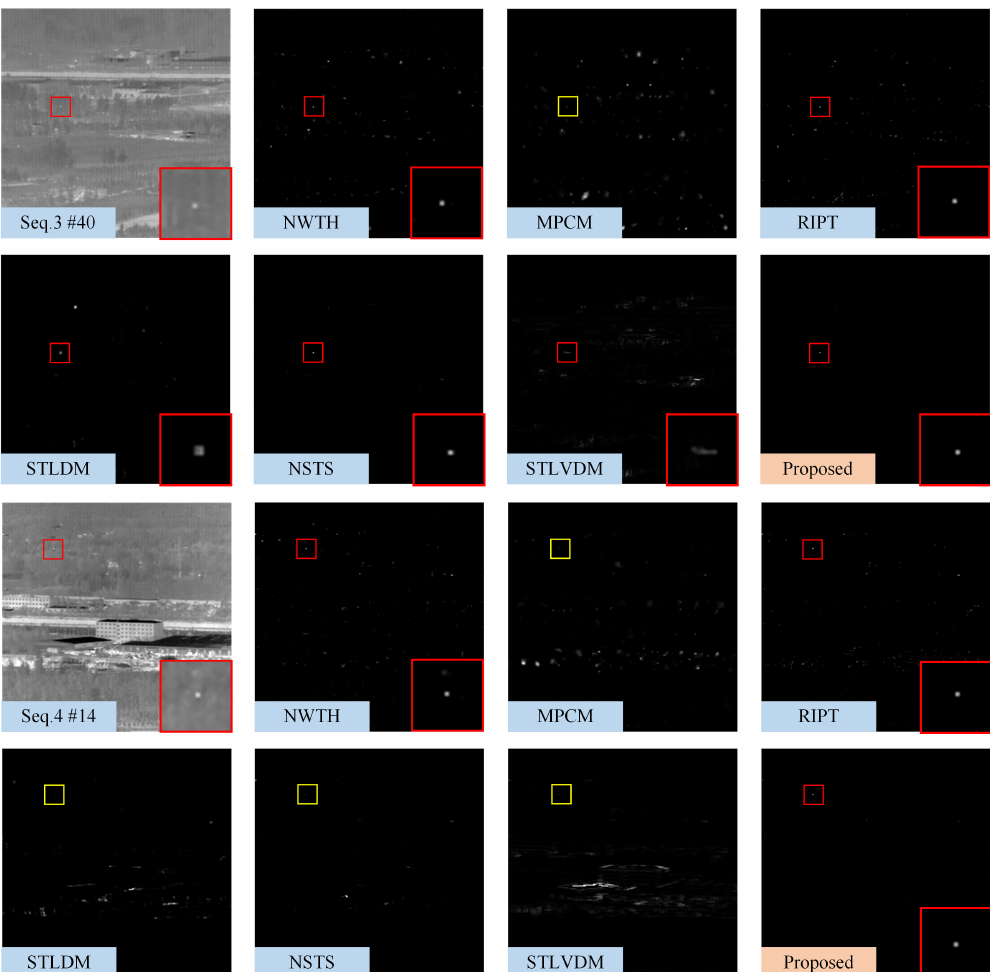
Figure 9. The saliency maps obtained by different methods on 40th frame in Seq.3 and 14th frame in Seq.4. For the sake of clarity, the real and detected target regions are marked with red boxes, and a close-up version is shown on each map. The yellow boxes denote missed